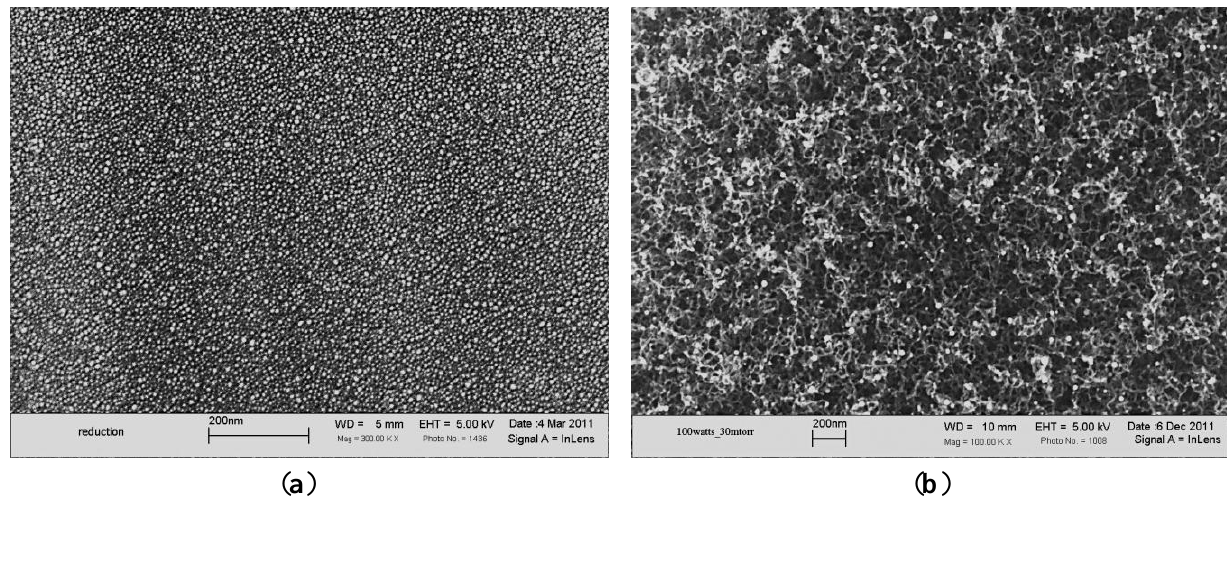
Figure 1. SEM micrographs for ( a ) nickel particles formed after the reduction process under N -H at 550 °C; ( b ) nanofilaments grown utilizing the graphitic structures by design 2 2 (GSD) technique with nickel particles attached to their